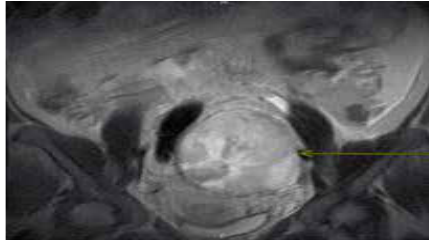
Figure 2: MRI pelvis without contrast coronal view revealed heterogeneous T2 hyperintense left ovarian mass measuring 12 × 9 × 10 cm (outlined by arrow).